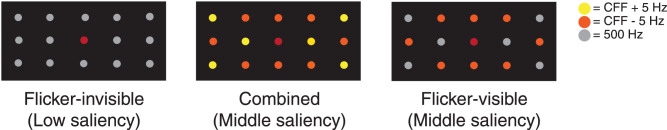
Conditions of the standard stimuli in Experiment 2. Except for fixation, all other colors are demonstrative. Stimuli were orange in the actual experiment. CFF = critical fusion threshold.